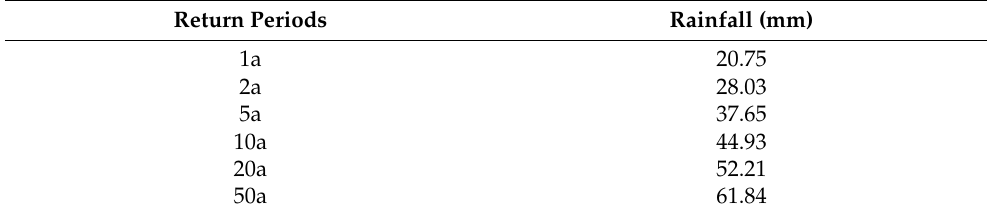
Figure 1. The situation in the study area: ( a ) Overview of the study area (base map from Google Earth); ( b ) The drainage system before the adjustment; ( c ) The drainage system after the adjustment; ( d ) The drainage system including a retention pond. Table 1. The design rainfall for different return